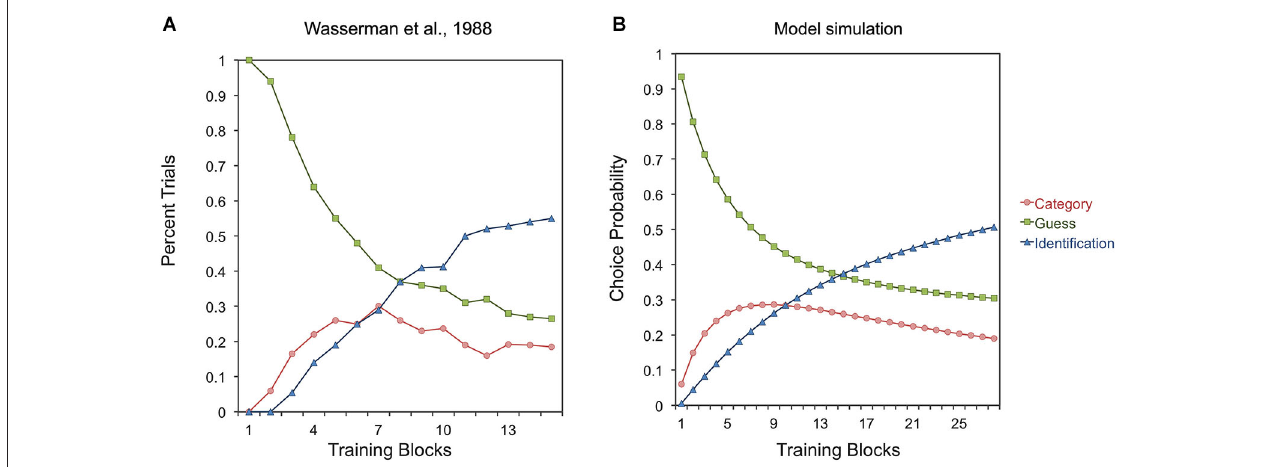
“Identification” and “Guess” series represent the proportion of trials in which pigeons and the model used categorization, identification or random guessing as a response strategy,